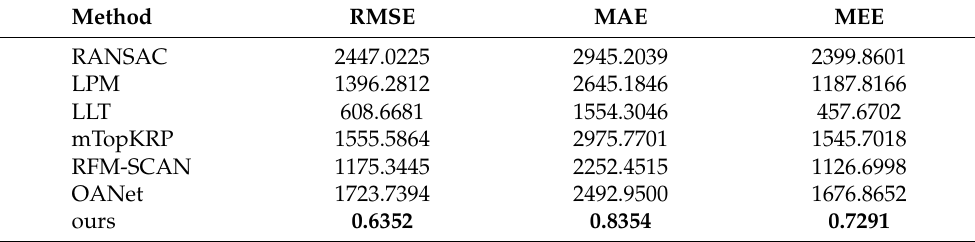
Table 3. Interband registration results of the seven methods for the OHS data. The RMSE, MAE, and MEE are used for the evaluation, and the best results are marked in bold.